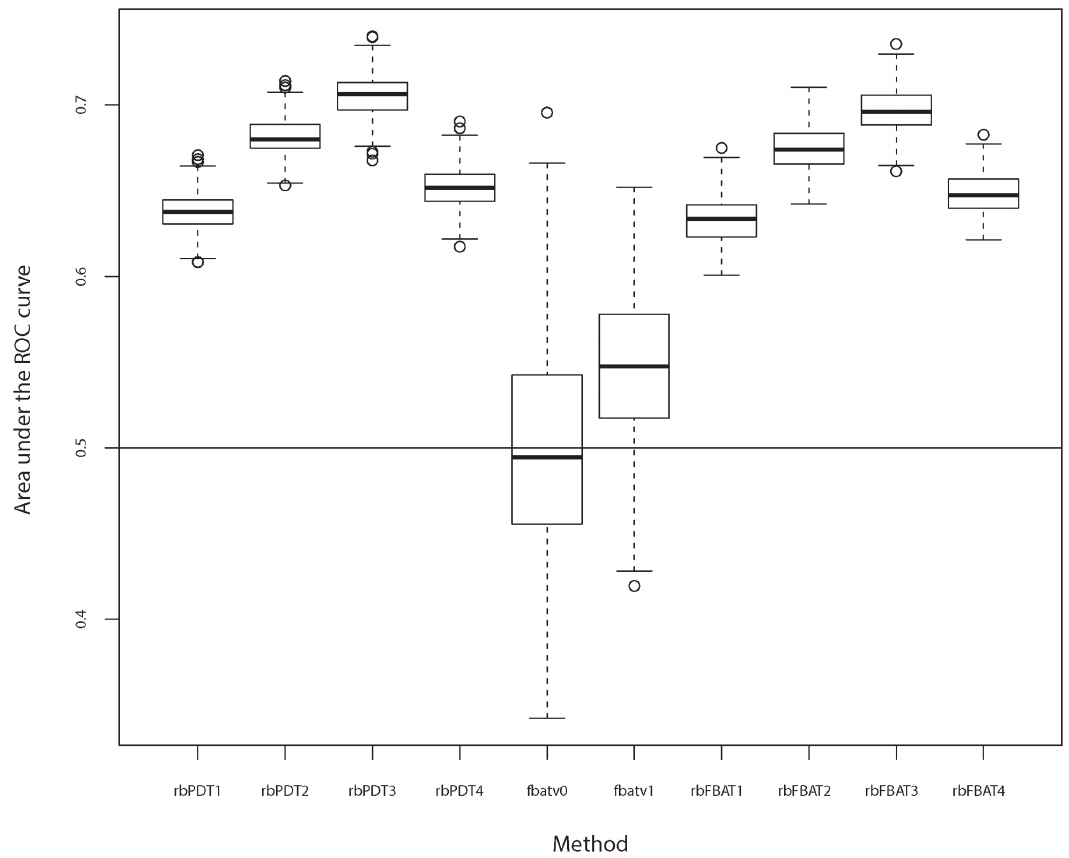
Figure 5. 200 replicate results: Boxplots of the area under the ROC curves for 200 replicates using fbatv0 , fbatv1 , and rbPDT and rbFBAT with four options.